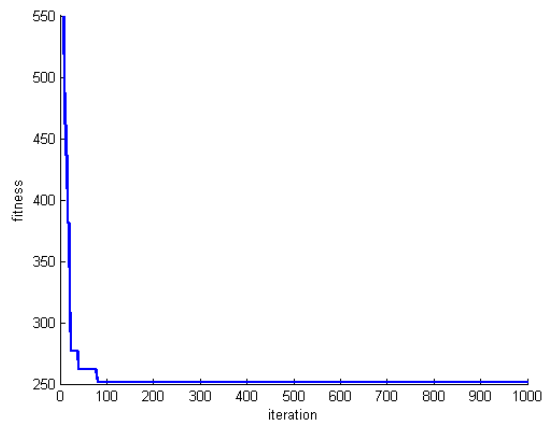
Sensors 2020 , 20 , x Figure 15. Changes of the best whale for 0 = a in 1 DS . Figure 15. Changes of the best whale for a = 0 in DS Figure 15. Changes of the best whale for 0 = a in 1 DS .